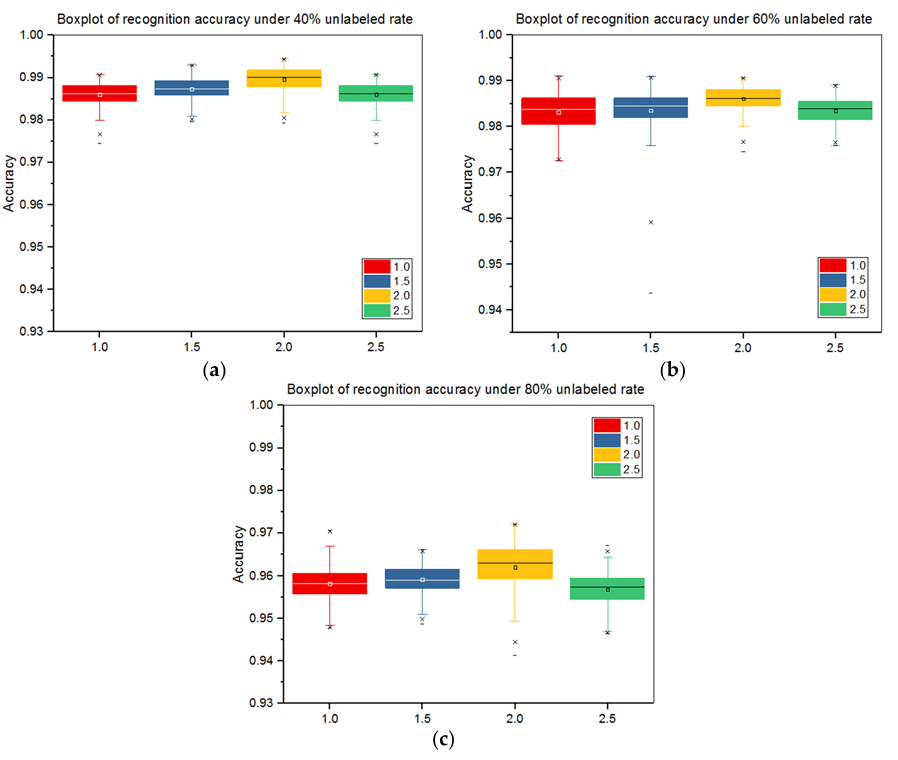
Figure 6. Boxplots of recognition accuracy: ( a – c ) correspond to unlabeled rate 40%, 60%, and 80%,